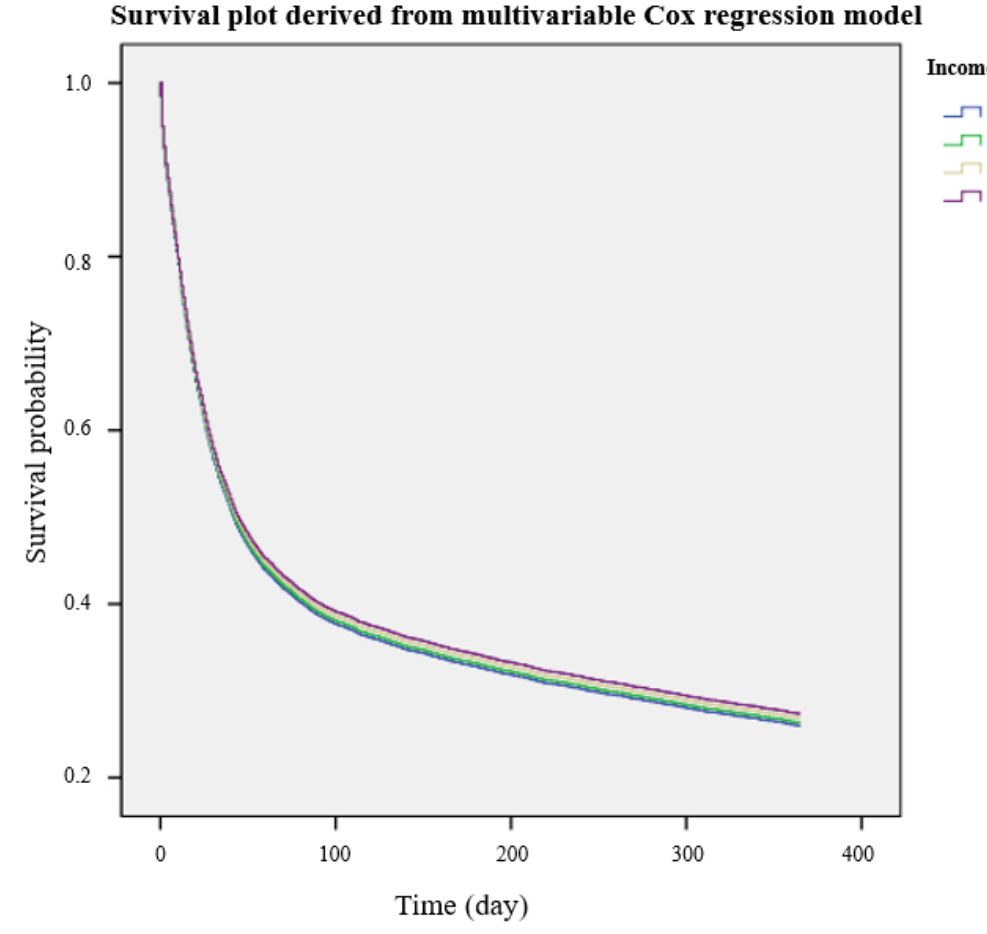
Figure 2. Survival among patients diagnosed with ARDS, based on their income level in the year preceding the diagnosis (estimates derived from the multivariable Cox regression model). ARDS, acute respiratory distress syndrome.